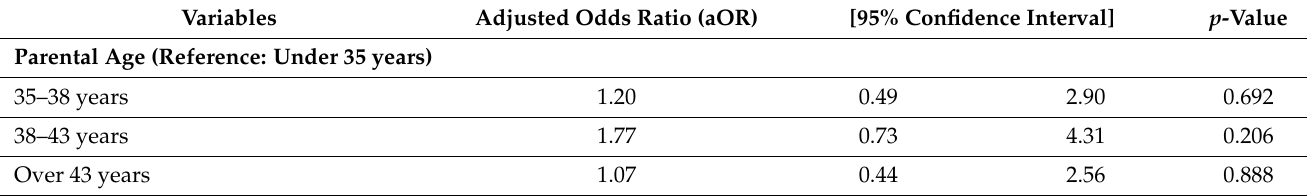
Table 2. Multivariable logistic regression results for two-dose COVID-19 vaccine receipt status of age-eligible eldest children of survey respondents ( n =